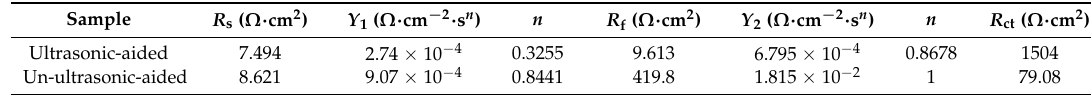
Figure 5. Equivalent circuit model used to fit the EIS data. Table 2. Fitting parameters calculated by an equivalent